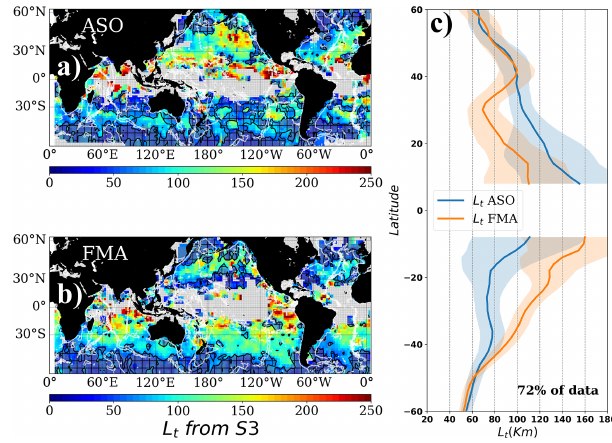
Figure 11. Same as Fig. 10, but for